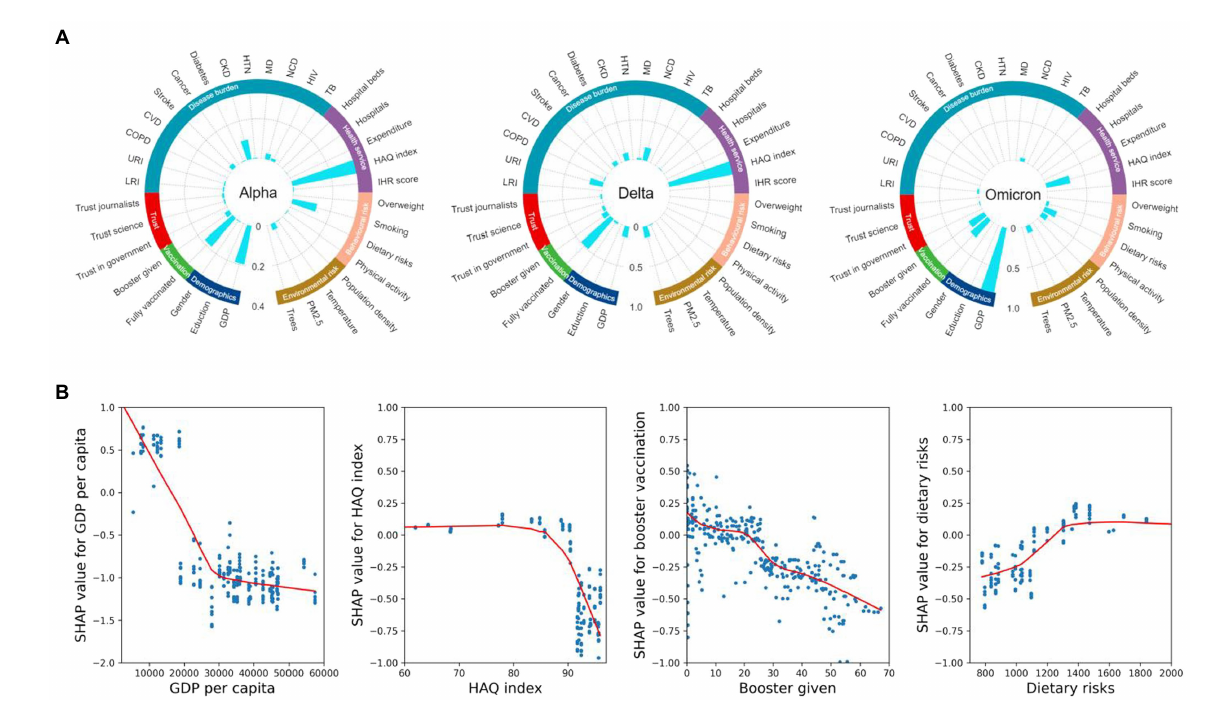
FIGURE 3 (A) Relative importance scores for each feature affecting age-adjusted CFR in each period model, obtained by taking the absolute mean of the SHAP values. The 35 features represent seven distinct dimensions: vaccination coverage, demographic factors, disease burden, behavioral risk factors, environmental risk factors, health services, and trust levels. (B) SHAP dependence plots for GDP per capita , HAQ index, booster vaccination rate, and dietary risks in the XGBoost models. SHAP values above zero represent an increased risk of higher COVID-19 age-adjusted CFR. LRI, lower respiratory infections; URI, upper respiratory infections; COPD, chronic obstructive pulmonary disease; CVD, cardiovascular diseases; CKD, chronic kidney disease; HTN, hypertension; MD, mental disorders; NCD, noncommunicable diseases; HIV, HIV infection; TB,